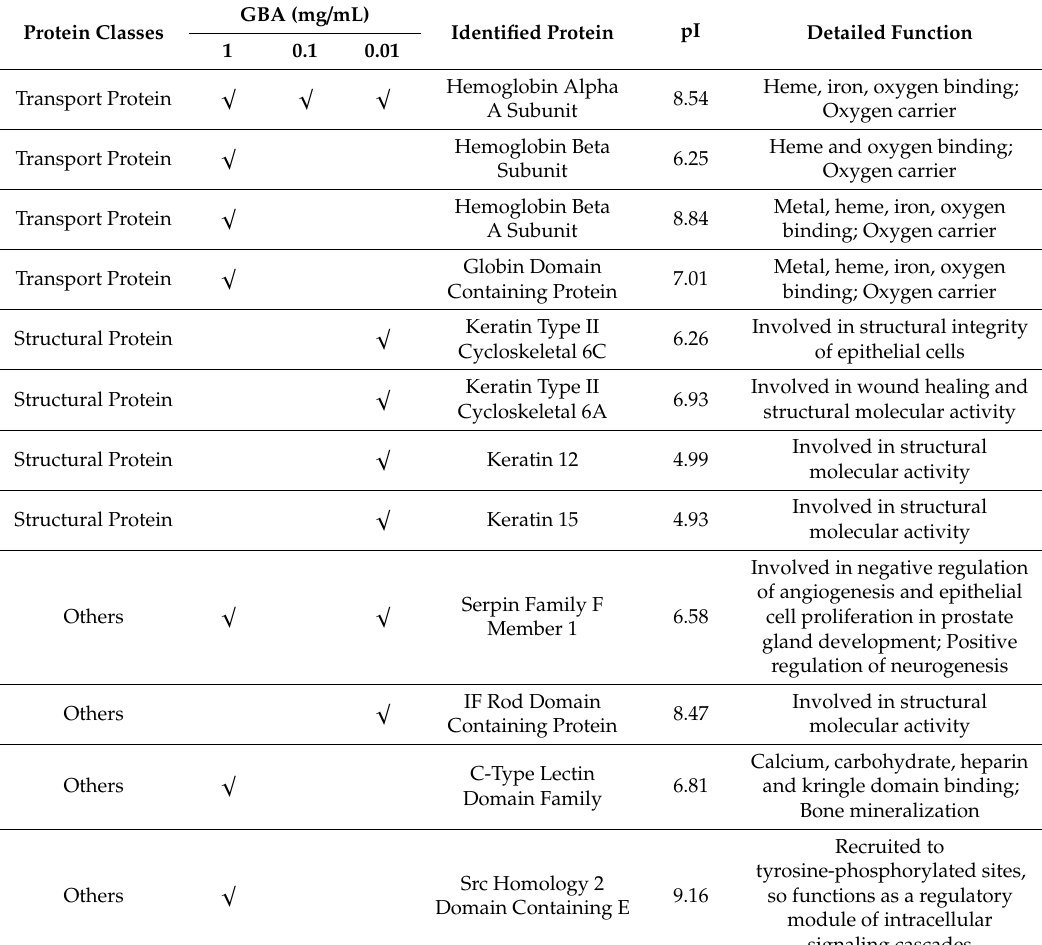
Table 7. List of identified proteins with di ff erent concentrations (0.01, 0.1, and 1 mg / mL) of GBA in 10% √ FBS. (Note: denotes the proteins identified at various concentrations of